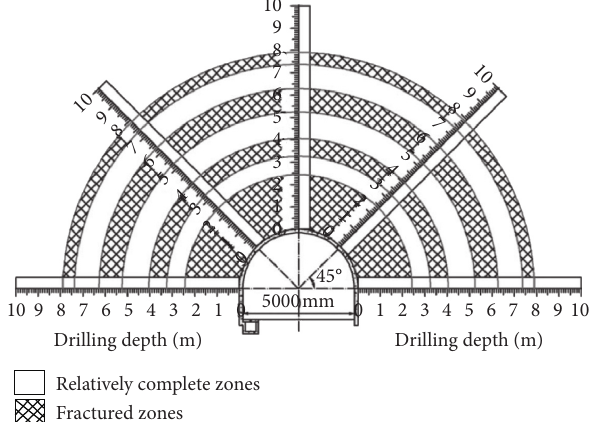
Figure 11: Failure distribution of model cavern after